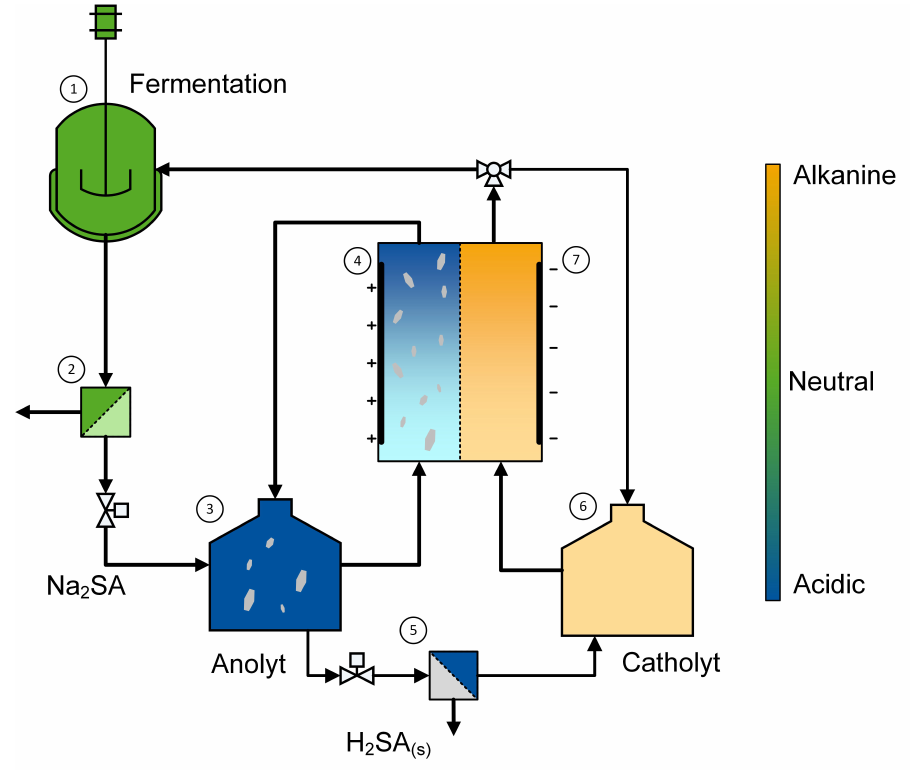
Figure 2. Electrified pH-shift downstream process for bio-based succinic acid adapted from Kocks et al. [19]: (1) fermentation at neutral pH value, (2) cell removal, (3) anolyt reservoir, (4) electrochemical acidification and pH-shift crystallization, (5) succinic acid crystal recovery, (6) catholyte reservoir and (7) electrochemical basification for pH-management in the